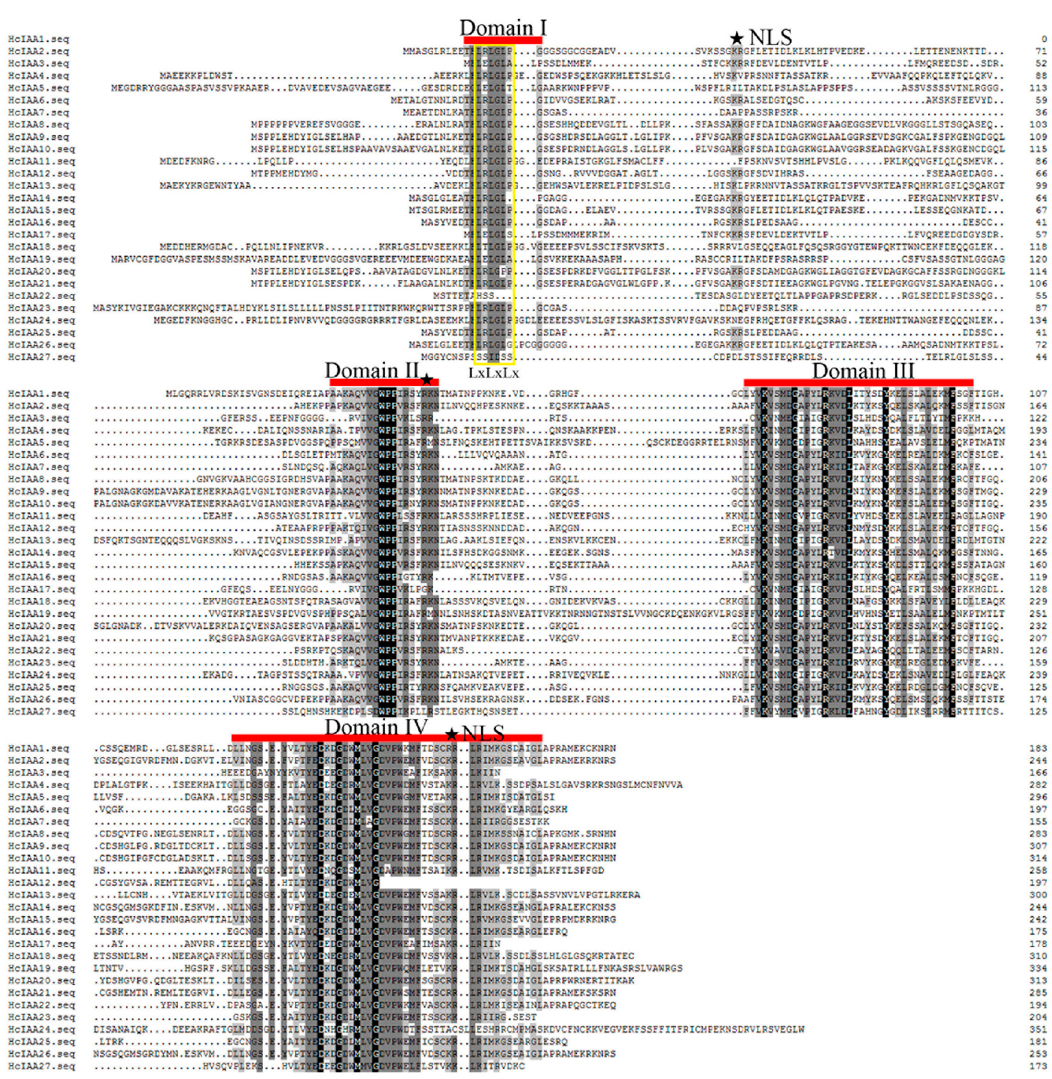
Figure 1. Multiple sequence alignment of the full-length HcIAA proteins obtained with Clustal W and manual correction. Domains I–IV of the H. coronarium IAA proteins are indicated with red lines. Color shading indicates identical and conserved amino acid residues. Nuclear localization signals (NLSs) are indicated by filled stars. The amino acid position is given to the right of each sequence. The yellow color box showed a typical LxLxLx motif present in domain I.